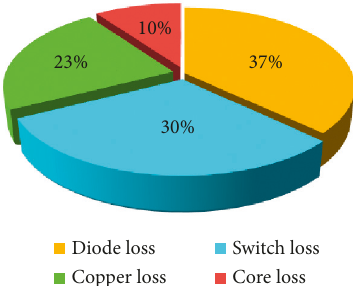
Figure 8: Distribution of losses in the circuit ESR of inductors is ignored. The ESR of all circuit capacitors except the output capacitor is equal to r